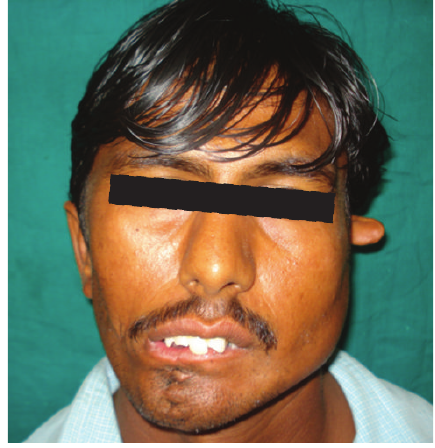
Figure 1: Frontal view.